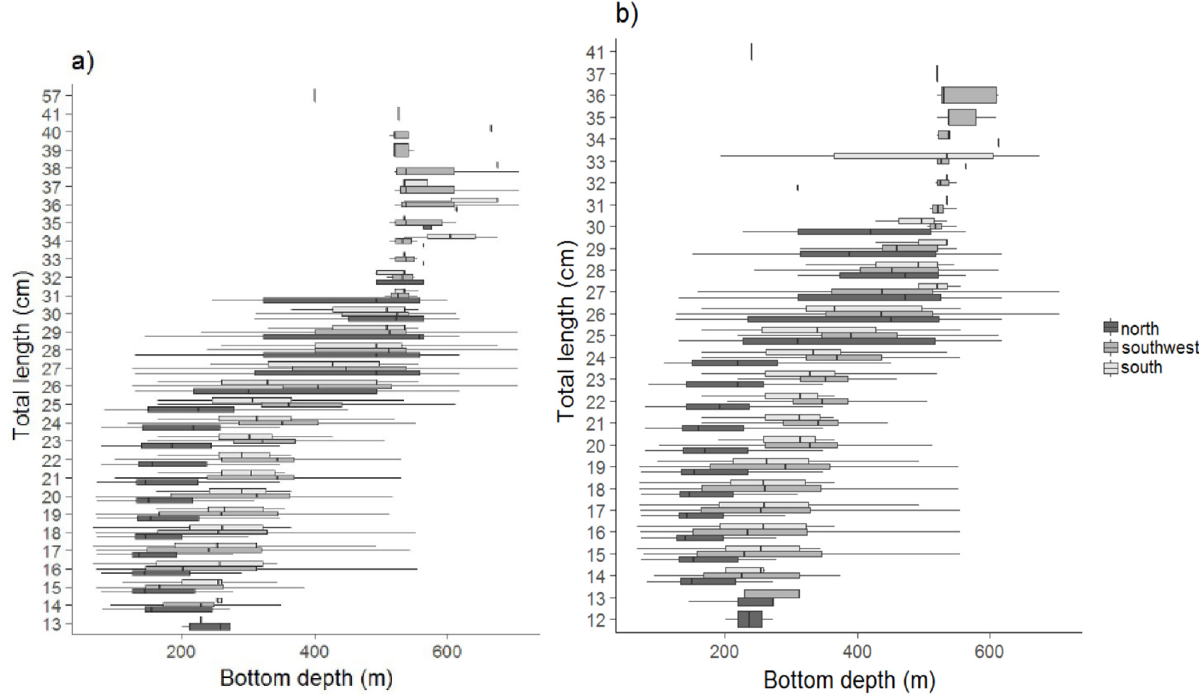
Fig. 2. Length (cm) distribution of blue whiting individuals by depth. (a) Females and (b) males. Sampling stations covered the depth range 20 – 750 m (see Fig. 1). The centre line of each box represents the median; the box limit indicates the 25th and 75th percentiles and the whiskers delimit the non-outliers